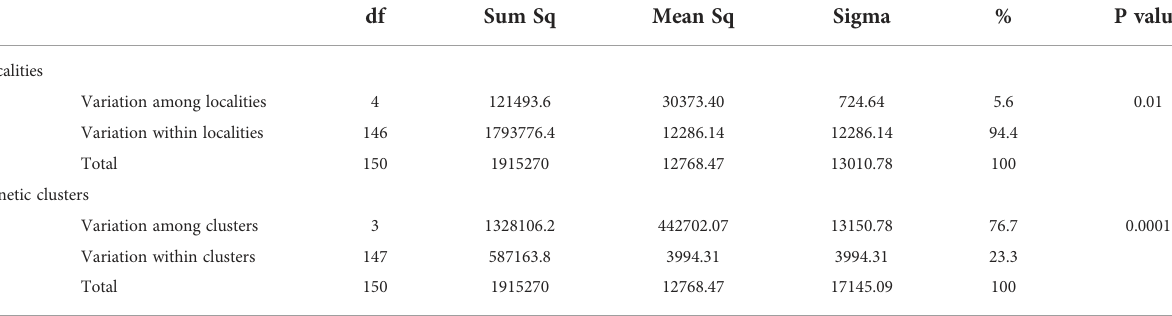
Sq, Sum of squares; %, Percentage of variation. TABLE 6 Genotypic and gene diversity indices of Bipolaris oryzae and Exserohilum rostratum isolates from fi ve rice-growing areas of Burkina Faso. B. oryzae population E. rostratum population N Clones Localities Bagre